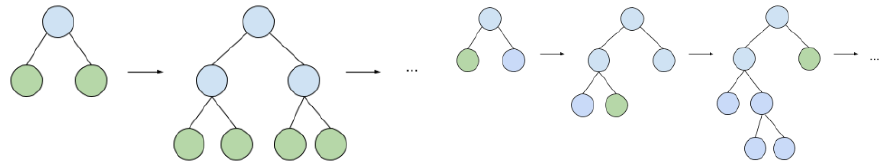
Figure 6. Two types of training: level-wise training ( left ), leaf-wise training ( right